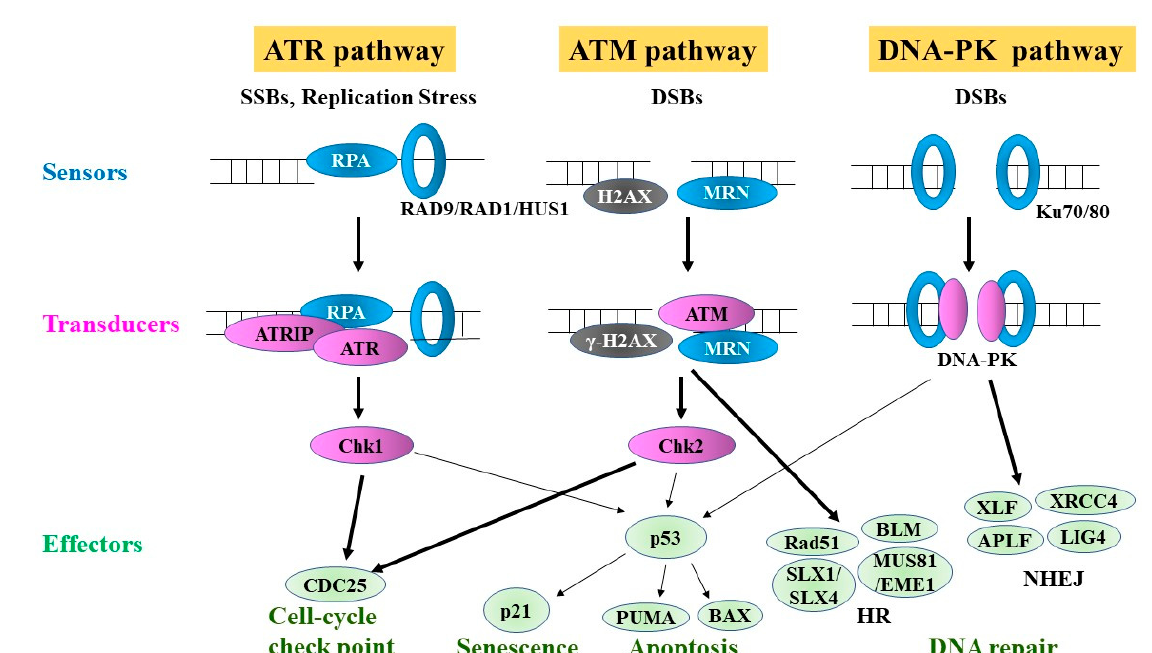
Figure 2. ATR, ATM and DNA-PK pathways. DNA damages are primarily detected by sensors (RPA, RAD9/RAD1/HUS1 complex, MRN complex, and Ku70/80 complex). Sensors recruit and activate transducers (ATR, ATM, DNA-PK, Chk1, and Chk2). Then, transducers phosphorylate numerous effector proteins to exert their functions, leading to senescence, cell-cycle checkpoints, apoptosis, and DNA repair. ATM and DNA-PK are responsible for the regulation of the HR and NHEJ, respectively. SSBs, single-strand breaks; DSBs, double-strand breaks; HR, homologous recombination; NHEJ, non-homologous end joining.